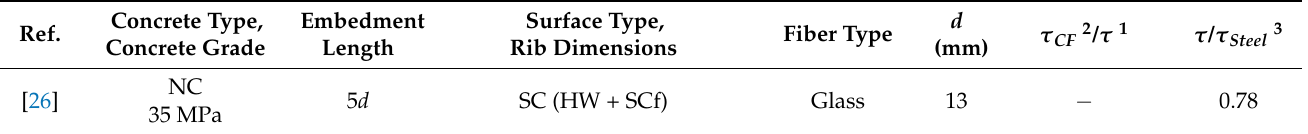
Table 2. Studies on the influence of fiber type on FRP–concrete bond